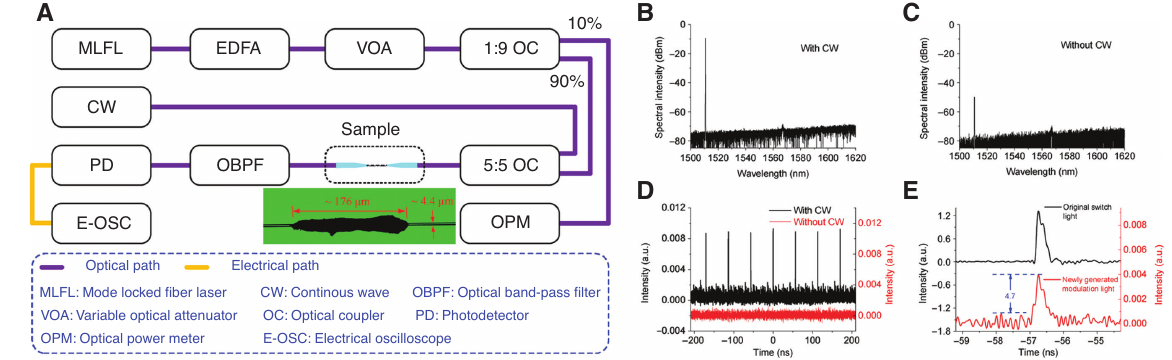
Figure 16: All-optical modulation based on a phosphorene-decorated microfiber. (A) Schematic diagram of the experiment setup. (B) Optical spectrum of the output light after the OBPF with CW on. (C) Optical spectrum of the output light after the OBPF without CW. (D) Waveforms of the output light after the OBPF with CW on or without CW. (E) Comparison of the single pulse waveform between the original switch light and the new modulation light. Reproduced with permission [271]. Copyright 2017 John Wiley and